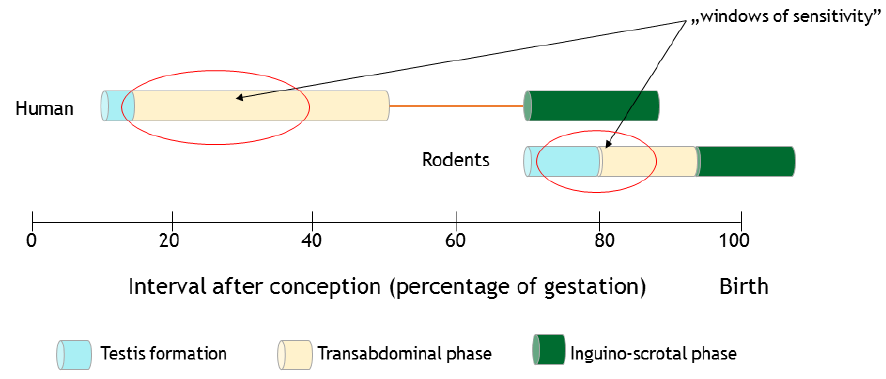
Figure 2. Schematic representation of the timing of masculine gonads formation. The transabdominal and inghino-scrotal phases of testicular descent in rodents and human are represented. Moreover, the estimated ‘windows of sensitivity’ toward endocrine disruptors affecting the male reproductive system are shown in red ovals.